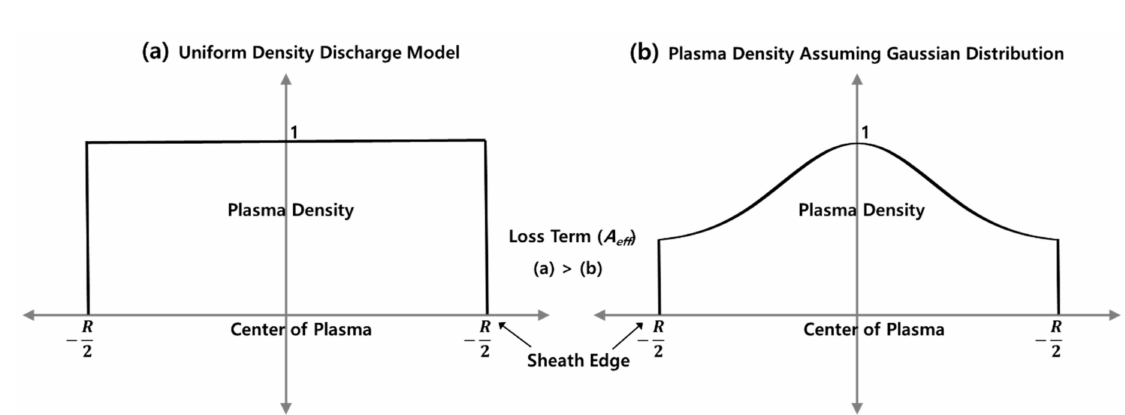
Figure 1. Comparison of plasma density distribution for the complement of A ef f for plasma particle losses: ( a ) uniform density discharge model and ( b ) plasma density assuming Gaussian